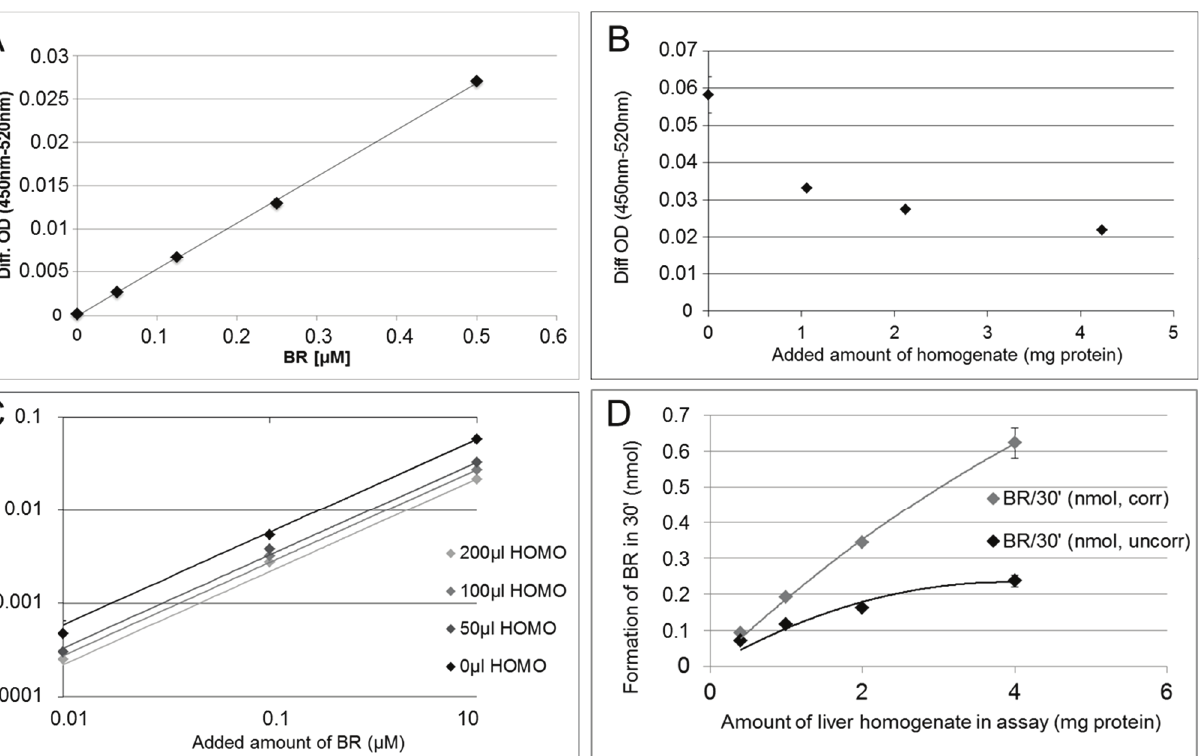
Figure 1. The tight interaction of BR with protein leads to underestimation of enzyme activities using the classical HO-assay. ( A ) Relationship between input and extractable amount of BR from HO-assay buffer (amount of BR was calculated using OD at 450 nm corrected for background OD at 520 nm (Diff. OD)) was linear (no protein added); ( B ) Presence of protein (liver homogenate: HOMO) in assay buffer supplemented with BR (1 μM) decreased the extractable amount of BR (Diff. OD); ( C ) Relationship between input and extractable amount of BR (0.01–1 μM) from HO-assay buffer (Diff. OD) was linear at constant protein concentration (added tissue homogenate (HOMO) with constant protein concentration of 10 mg protein/mL); ( D ) Using the polynomial for correcting the BR amount, the activity of HO (formation of BR/30 min) depended nearly linearly on the amount of liver homogenate used for the